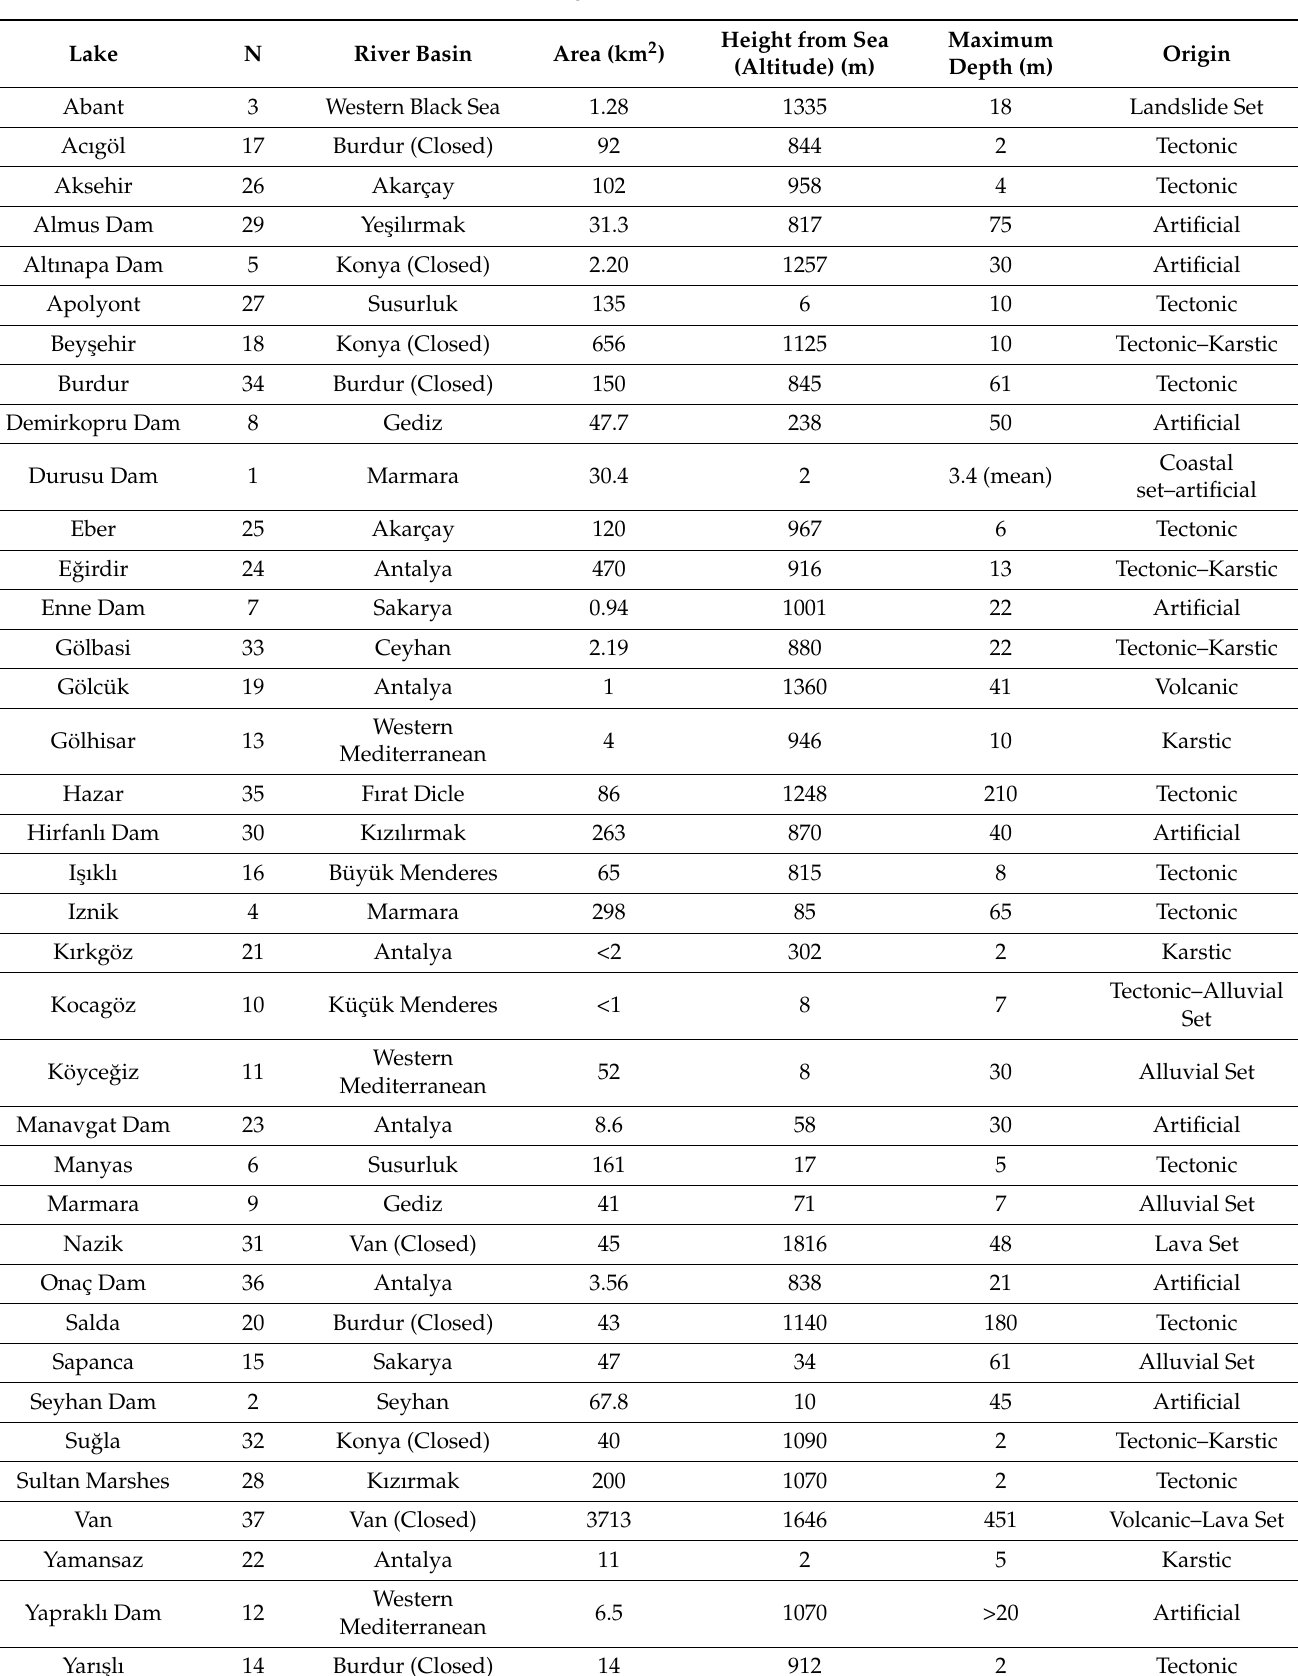
Table 1. Details of physical characteristics (area, water depth, elevation), the river basin, and the origin for each of the 37 considered Turkish lakes (N: lake number in Figure 1 from west to